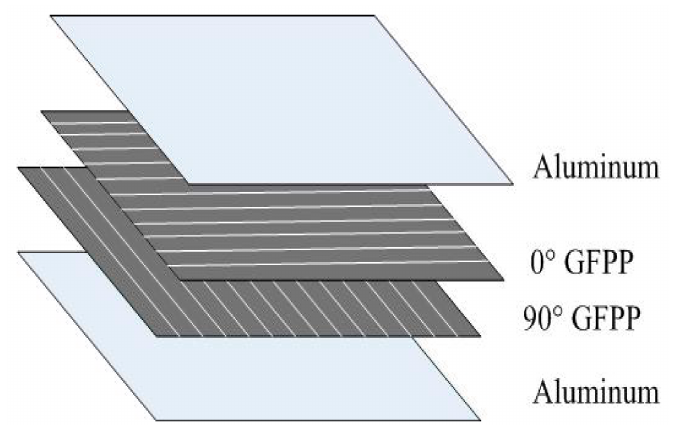
Figure 1. Lay-up of fiber metal